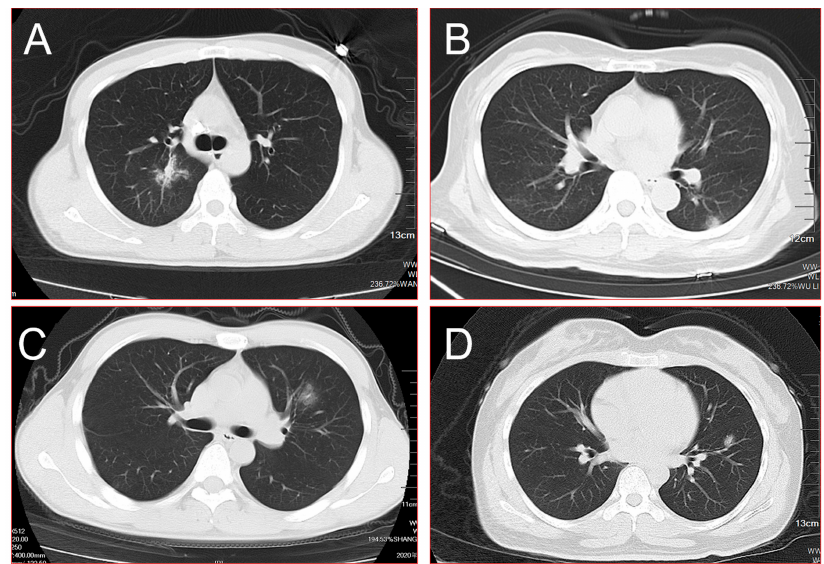
Figure 2. ( A ) Burr sign, lobulated sign, pleural indentation, and cavity could be seen in the central area of the right upper lobe simultaneously; ( B ) a single mixed ground-glass shadow was present in the peripheral area of the left lower lobe on admission; ( C ) a single ground-glass shadow with the blurred border was found in the left upper lobe; ( D ) a single mixed ground-glass shadow combined with cavities was found in the left upper lobe. All of these SPNs were finally identified as high-risk nodules using the AI system and were confirmed as COVID-19 through throat-swab RT ‒ PCR. Table 5. CT findings and AI results of COVID-19 patients with SPN.